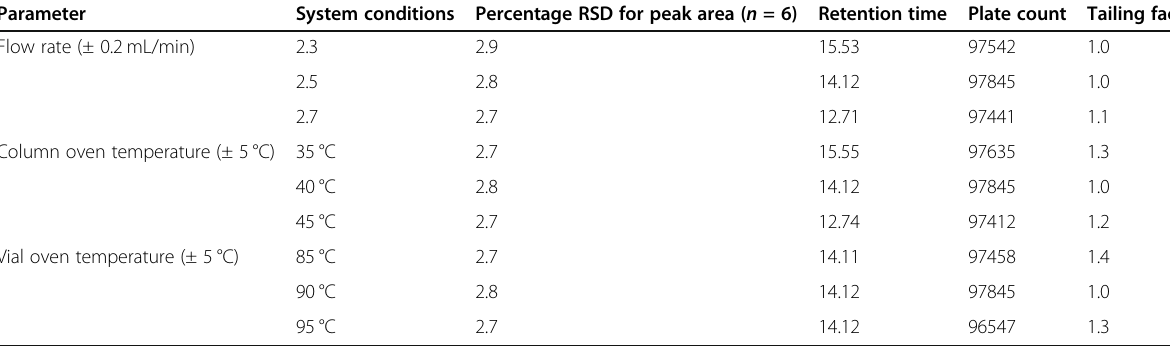
Table 26 Robustness study results of tetrahydrofuran Parameter